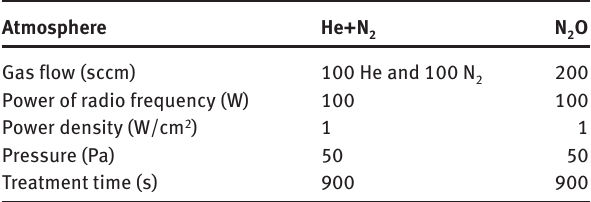
Table 1: Conditions of the RF-plasma treatment of PEEK samples